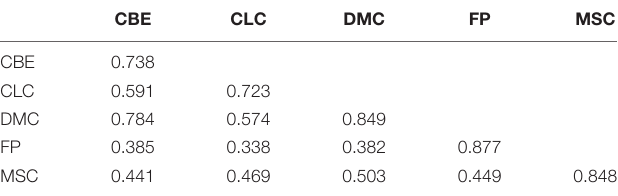
TABLE 2 | Discriminant validity.